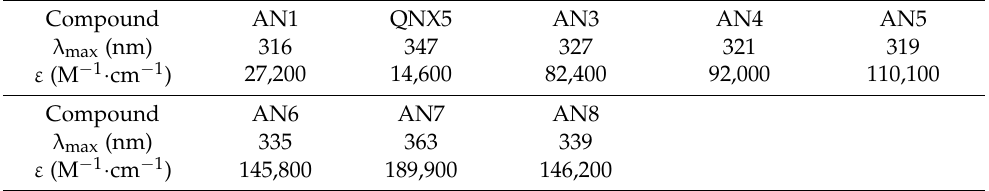
Figure 11. Chemical structures of various acenaphthoquinoxalines AN1, AN3-AN8 and 2-mercaptobenzoxazole used as the hydrogen donor. Table 4. Optical characteristics of various acenaphthoquinoxalines in